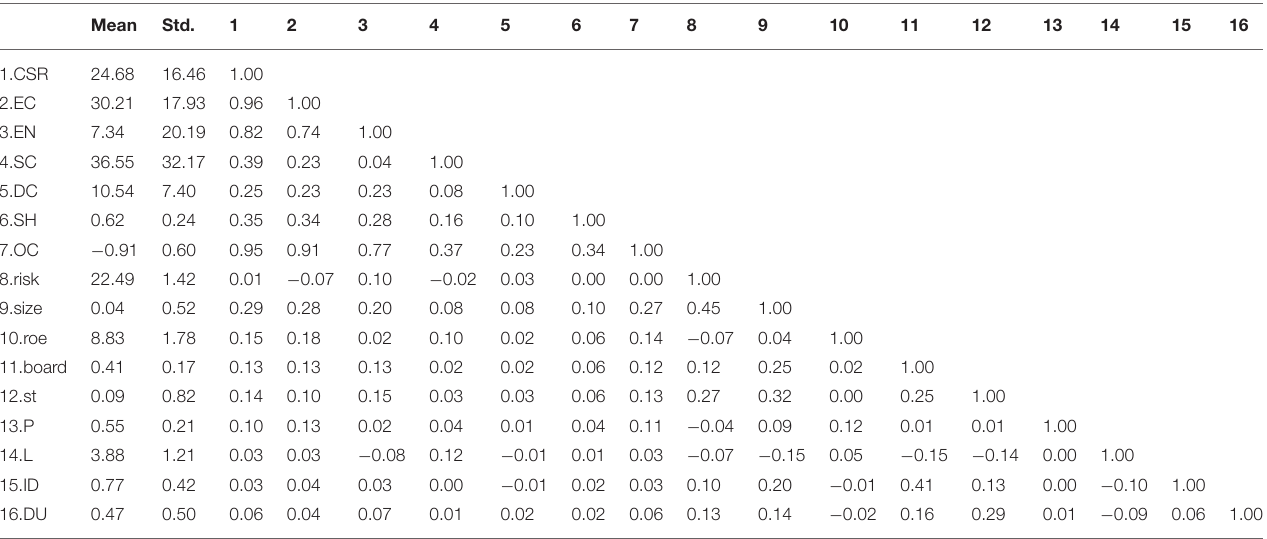
TABLE 2 | Results of descriptive statistics and multicollinearity test. Mean